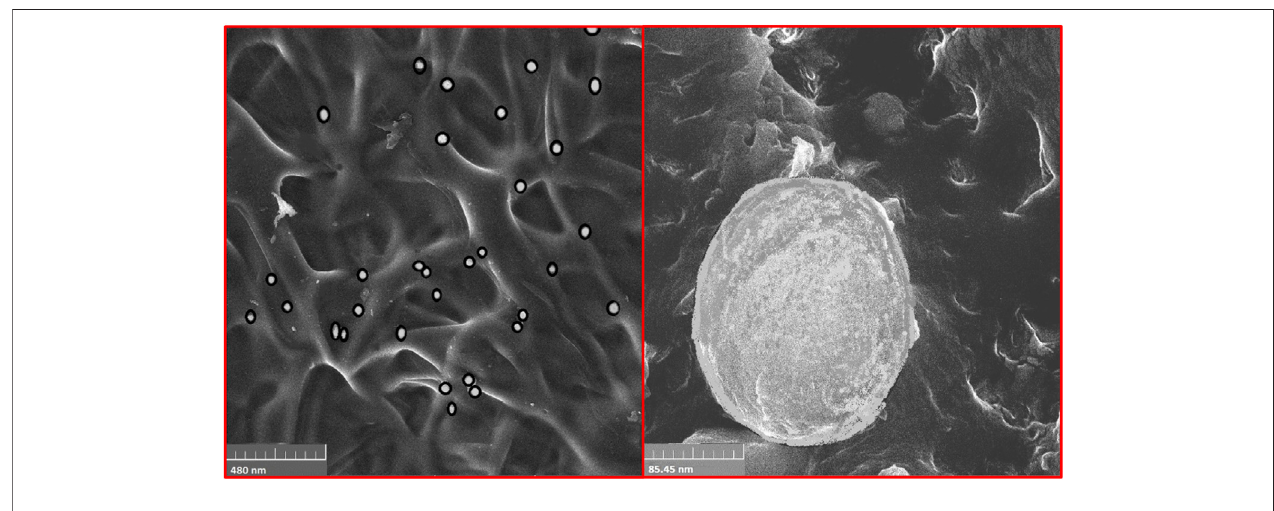
FIGURE 4 | SEM analysis of EN-TA-MSNs.